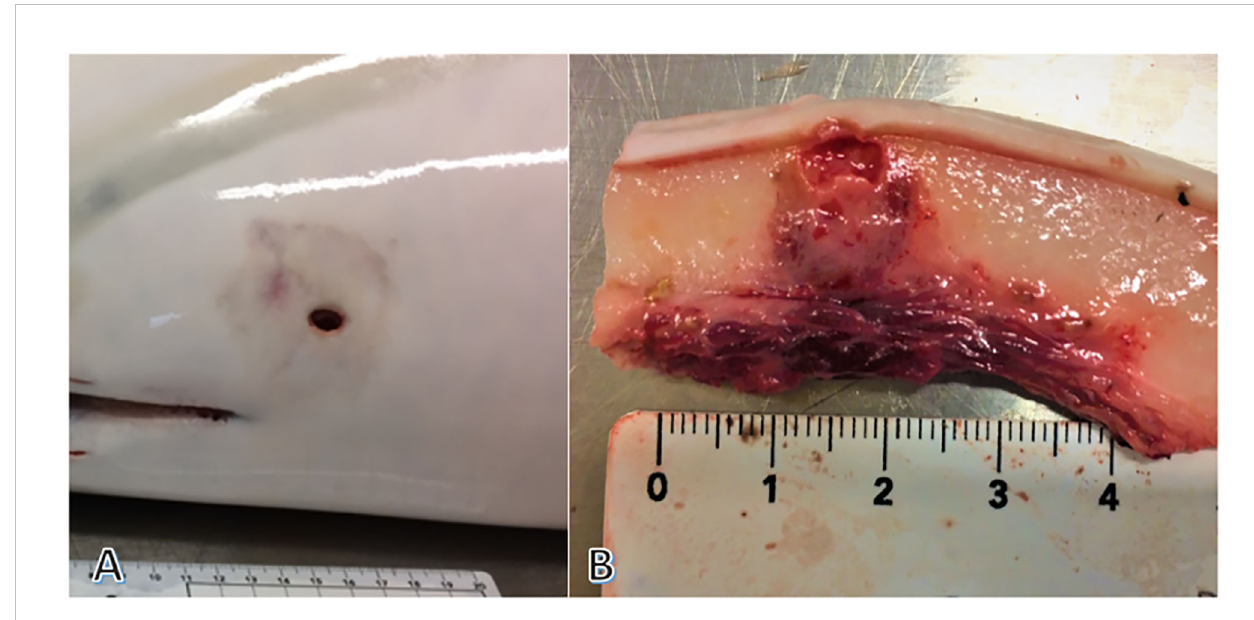
FIGURE 3 Skin lesion in external view (A) and cross-section (B) , © PELAGIS.